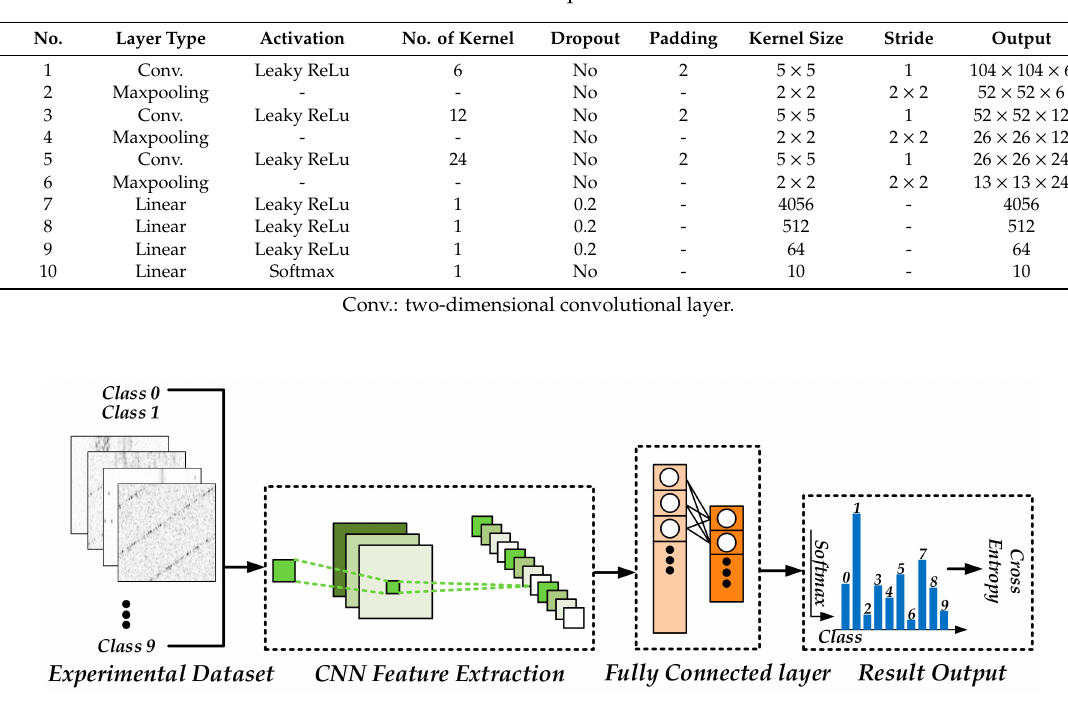
Figure 7. The flowchart of the proposed methodology (TDV-CNN).